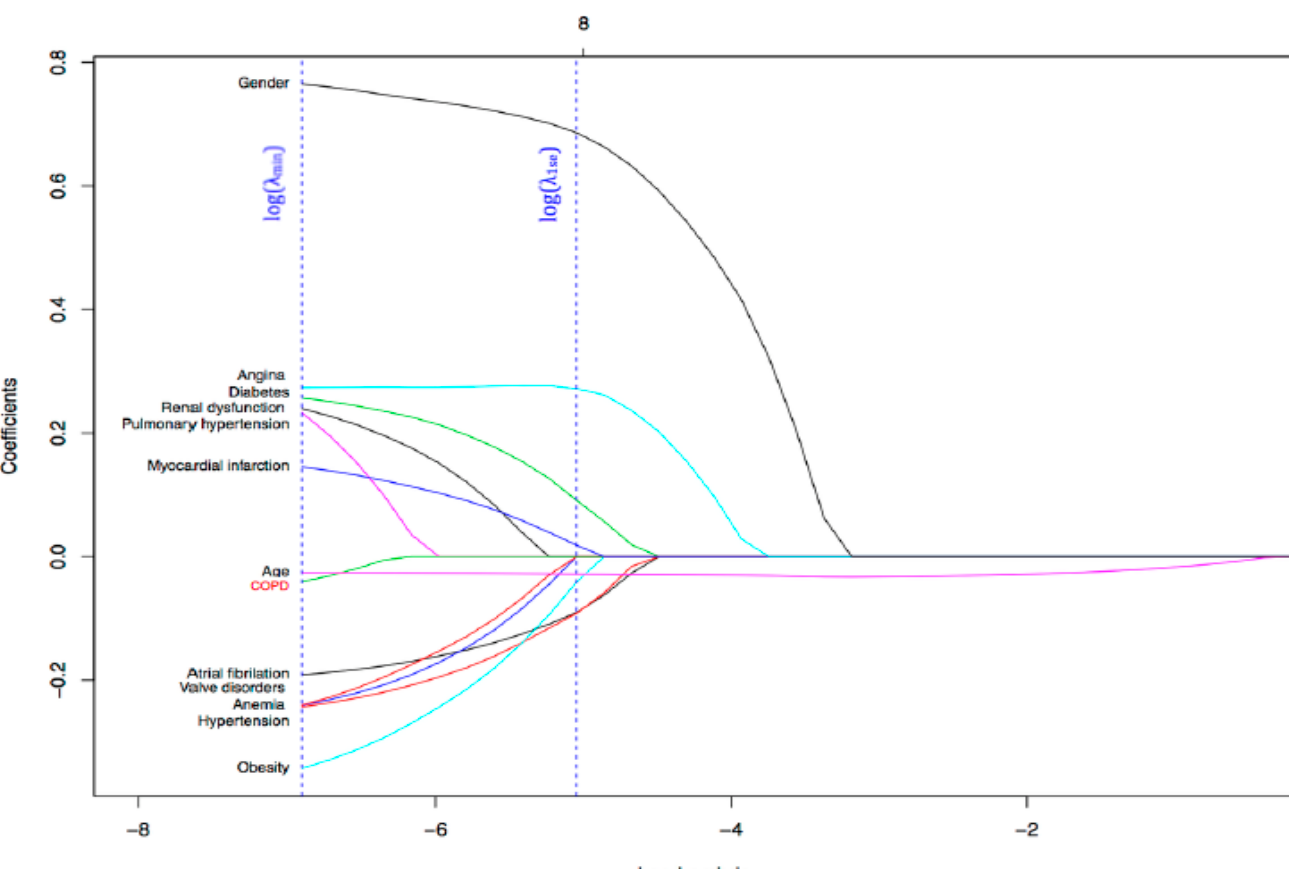
Figure 2. The most relevant coefficients of the model based on their contribution in the EF class prediction. On the x -axis, Log Lambda refers to the logarithmic of the regularization parameter ( λ ), which controls the weight that each variable has in the model.